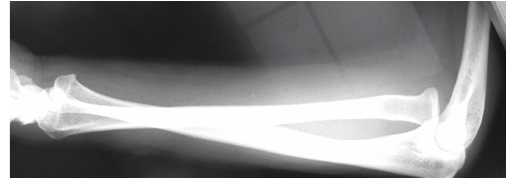
Figure 1: Radiographic findings at the first medical examination. From lateral view, radius head was dislocated anteriorly and distal end of radius was dislocated posteriorly. Radius and ulna were found to have the shape of letter X.